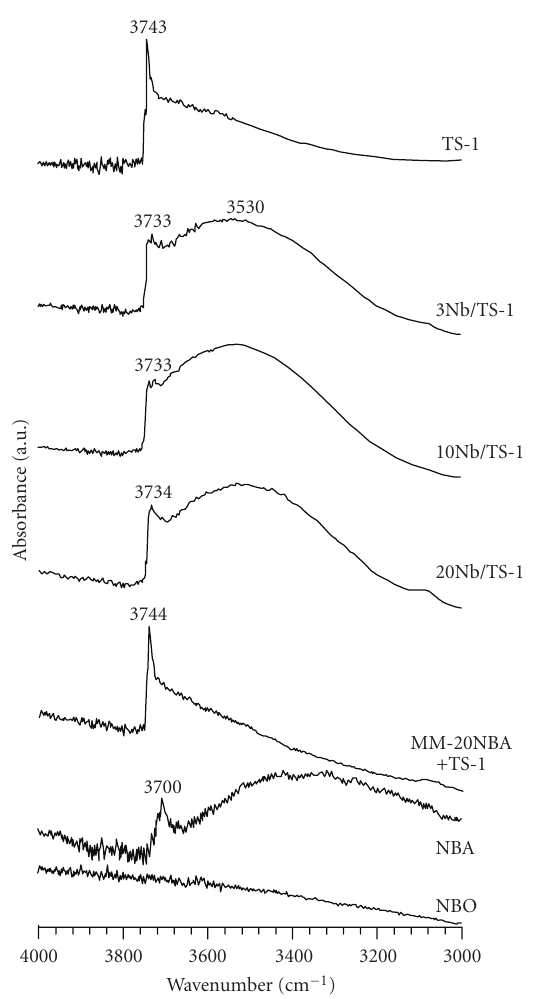
Figure 5: FTIR spectra of the NBA, NBO, TS-1, and X Nb/TS-1 samples in the hydroxyl vibration region, after evacuation under vacuum at 200 ◦ C.